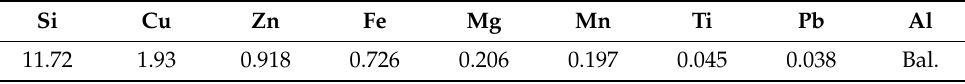
Table 1. Chemical composition (wt%) of A383 alloy used as the matrix